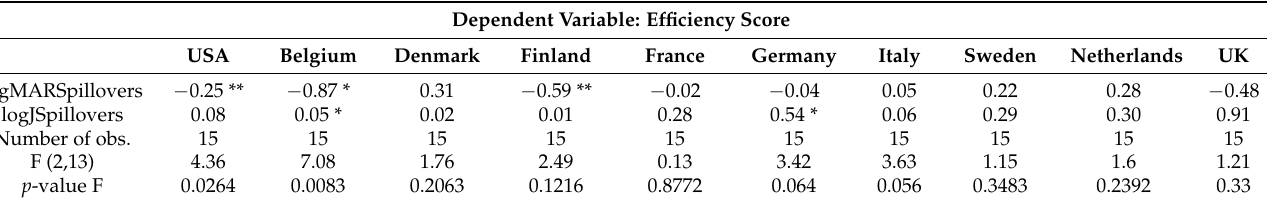
Table 7. Tobit regression by country (average marginal effects).